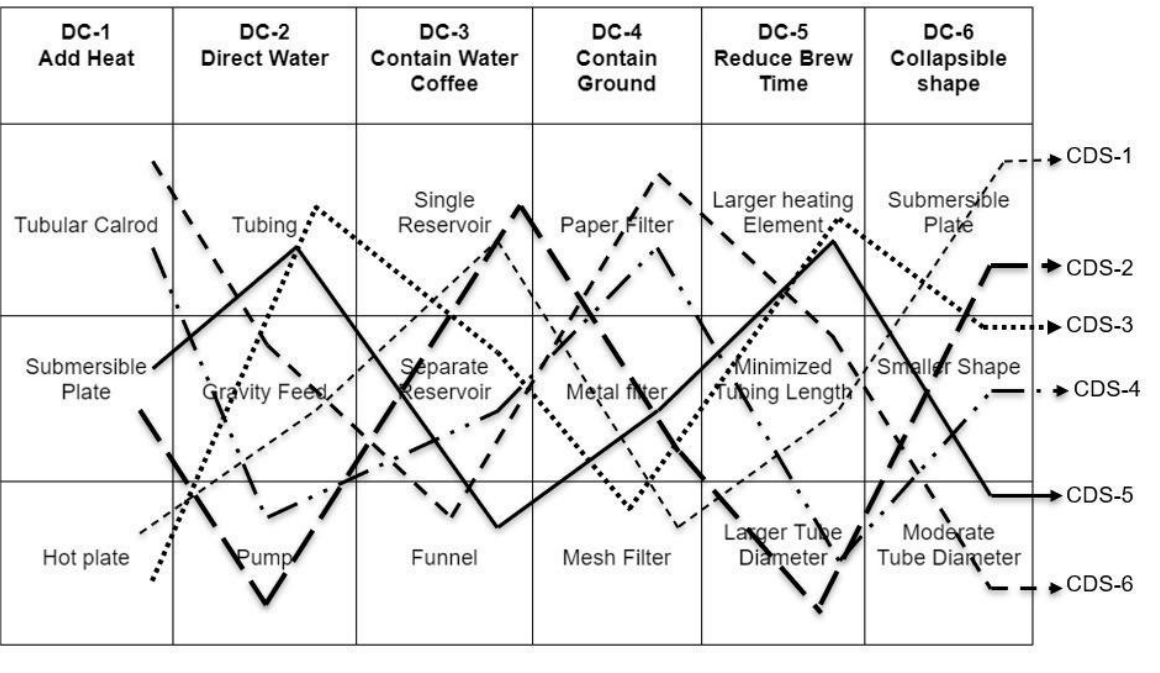
Different set of design solutions and complete design solutions for concept design